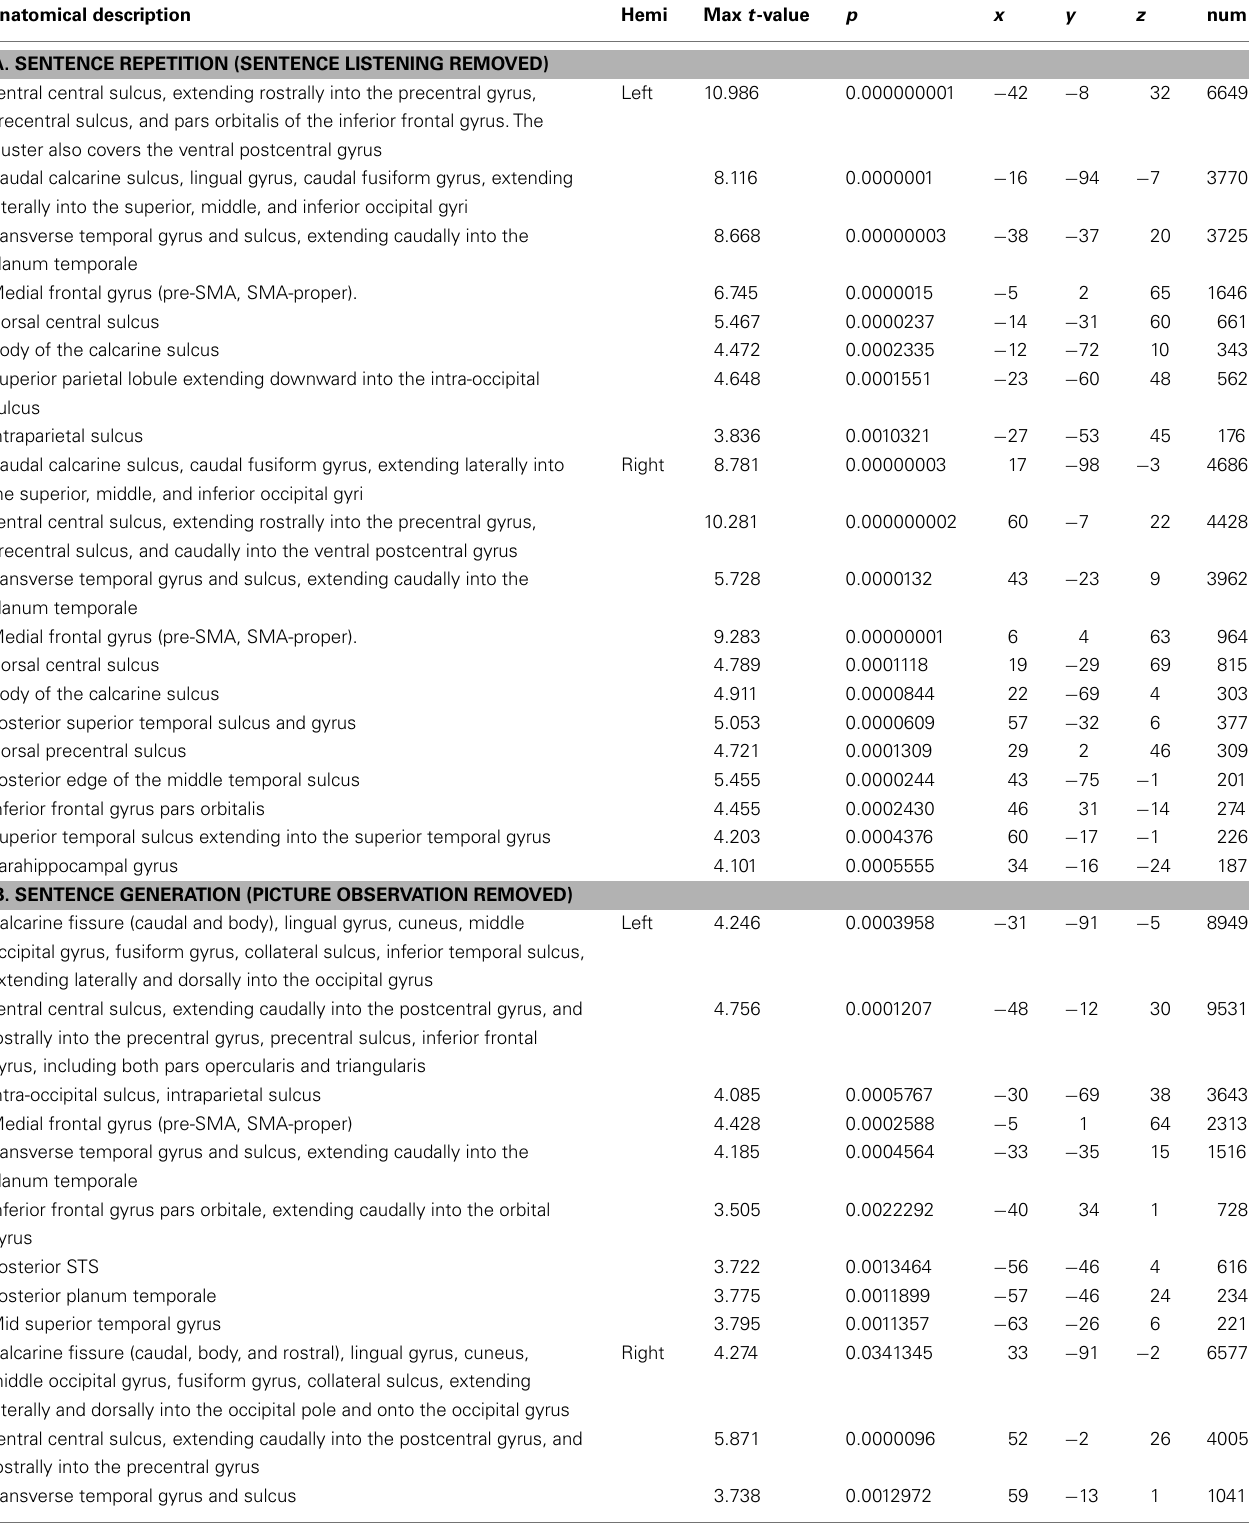
Table 3 | Family-wise error-corrected group-level ( N = 20), cortical surface results for the contrast of (A) Sentence Repetition against Sentence listening, and (B) Sentence generation against picture